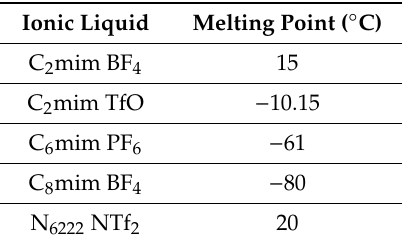
Table 1. Melting point of common ionic liquids [85].